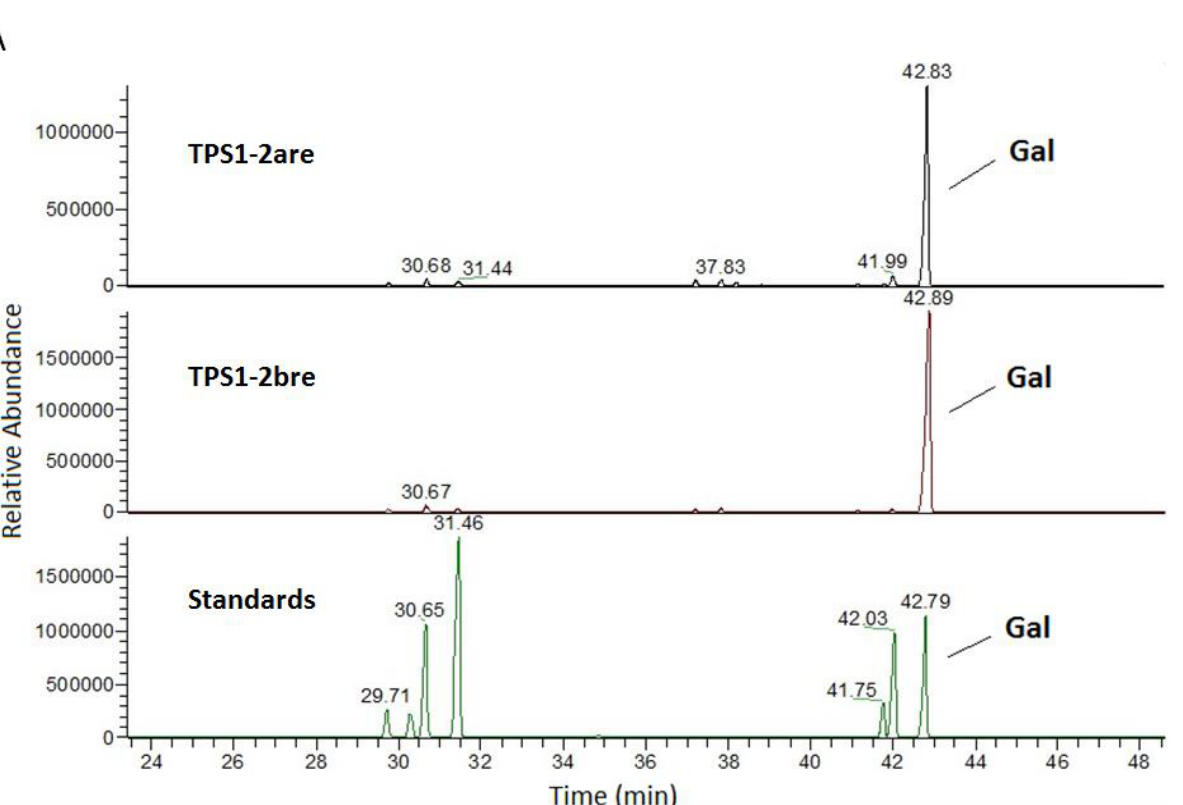
Figure 4. ( A ) Monosaccharide composition of TPS1-2are and TPS1-2bre, reduced form of TPS1-2a and TPS1-2b, respectively; ( B ) Configuration of TPS1-2are and TPS1-2bre comparing to D -Gal and L -Gal